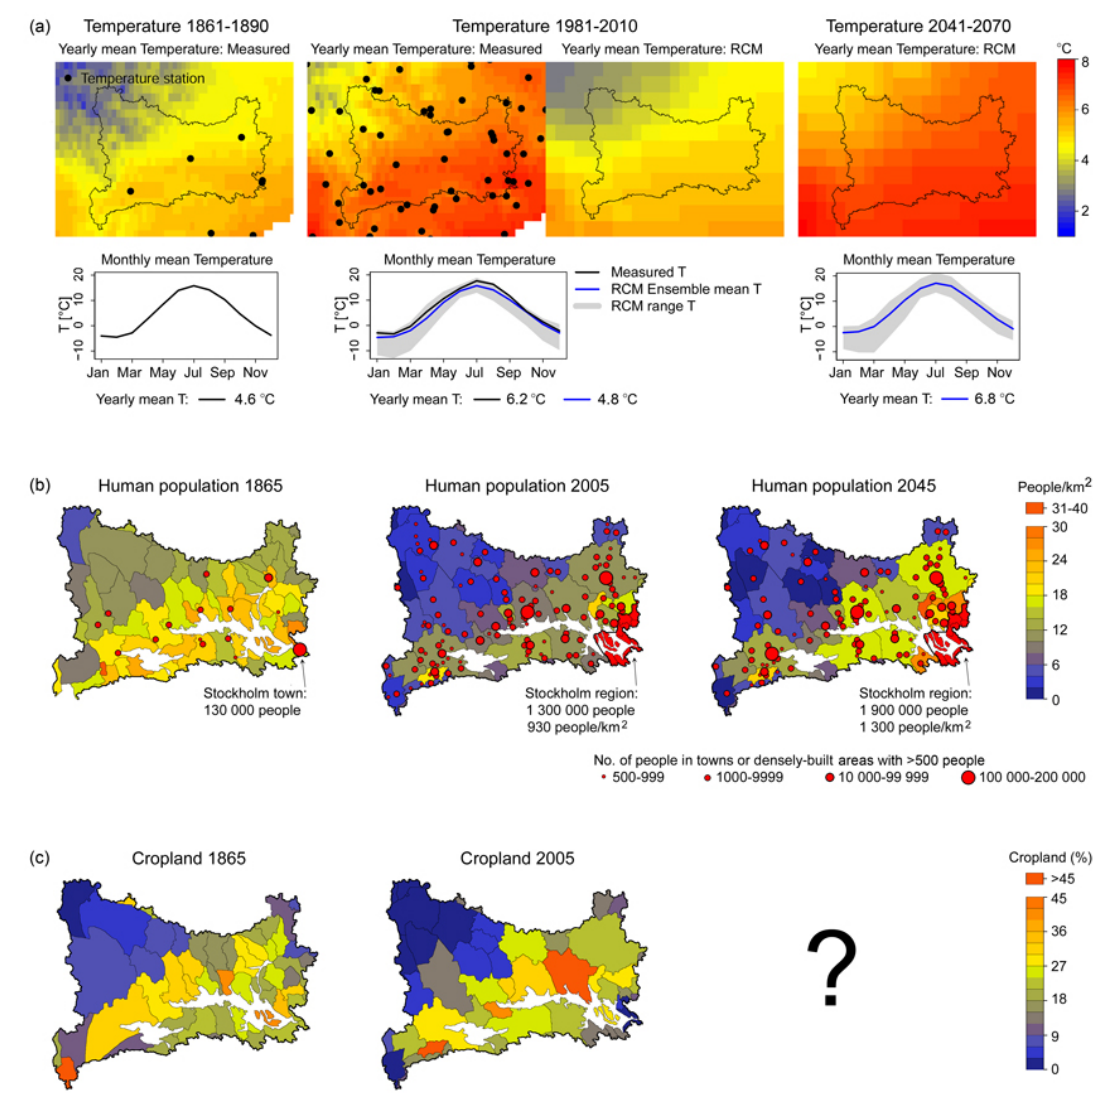
Fig. 2 . Climate, human population, and land use in NDB in the 19th century and at present (2000s), as well as climate and human population projections for the mid-21st century. a) Mean annual temperature and temporal distribution of monthly mean temperature. Figures to the left and middle/left show measurement points (temperature stations) and mean temperature calculated as gridded interpolations between measurement points. Figures to the right and middle/right show ensemble mean temperature (and spreading around the mean) for 24 climate model projections. b) Human population density in rural areas and population size in densely-built areas. c) The proportion of cropland in judicial districts (1865) and municipalities